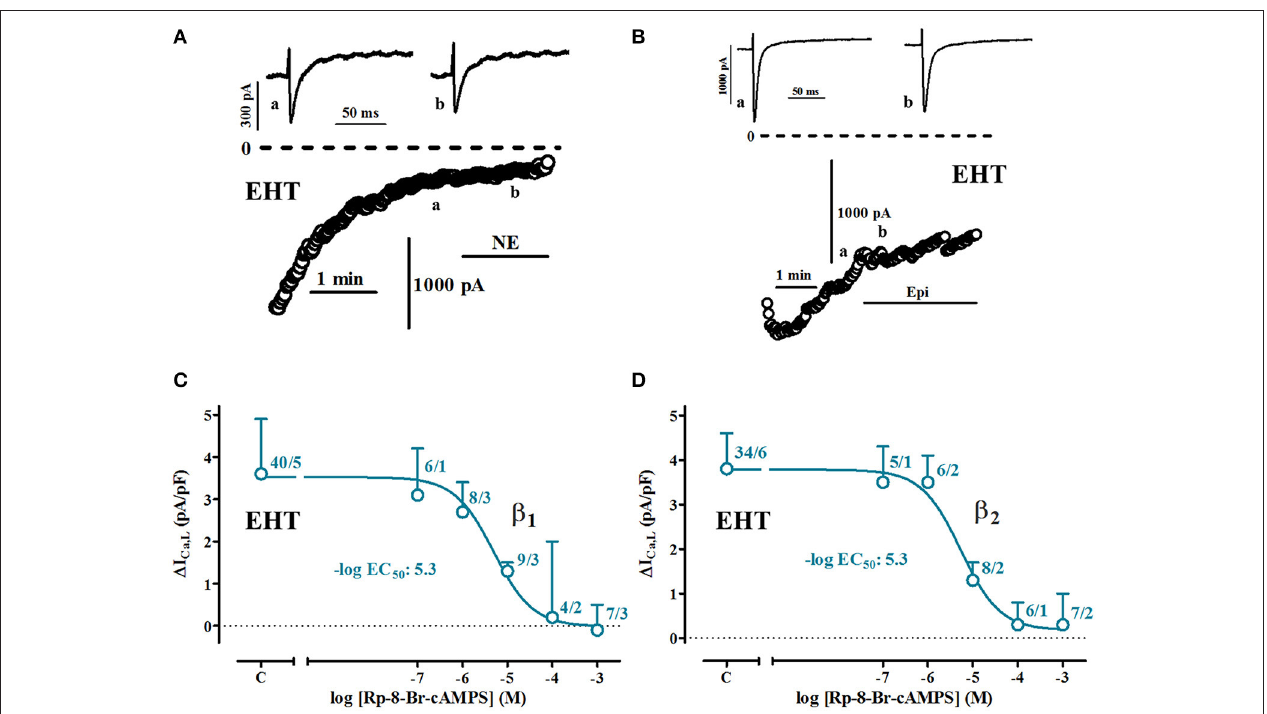
FIGURE 7 | PKA-dependency of β 1-and β 2-AR-mediated increases of ICa,L in EHT. (A,B) Time course of ICa in cells exposed to norepinephrine (NE) and epinephrine (Epi, each 100 µ M) when intracellularly perfused with Rp-8-Br-cAMPS (1 mM). Original tracings taken at time points indicated as a and b. (C,D) Concentration-response curves for the inhibition of β 1-and β 2-AR mediated increases of ICa,L in EHT. In all experiments concentration of NE or Epi was 100 µ M. N/N indicates number of cells vs. number of isolation for EHT.